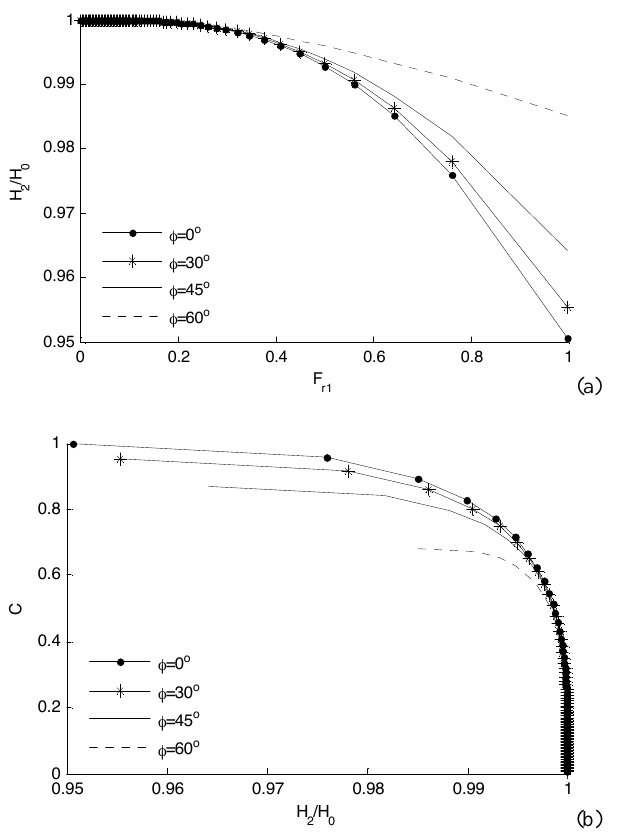
Fig. 8. Discharge coefficient variation according to Borghei et al. (2003), (a) discharge reduction coefficient for imperfect weir ( C d ), (b) and free-flow discharge coefficient ( C df ). values of d/1 . For that reason it is not strange that the C df value varies. The definition of C d is a bit simpler. The graph (Fig. 8) shows the effect that a larger inclination leads to a smaller